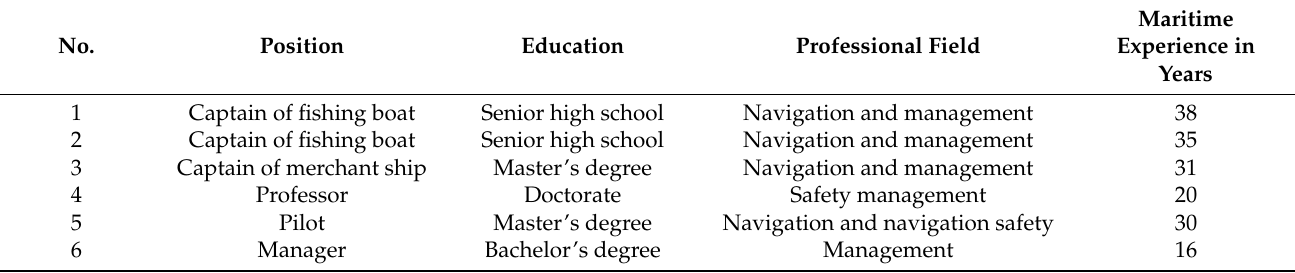
Table 1. Decision-making group.